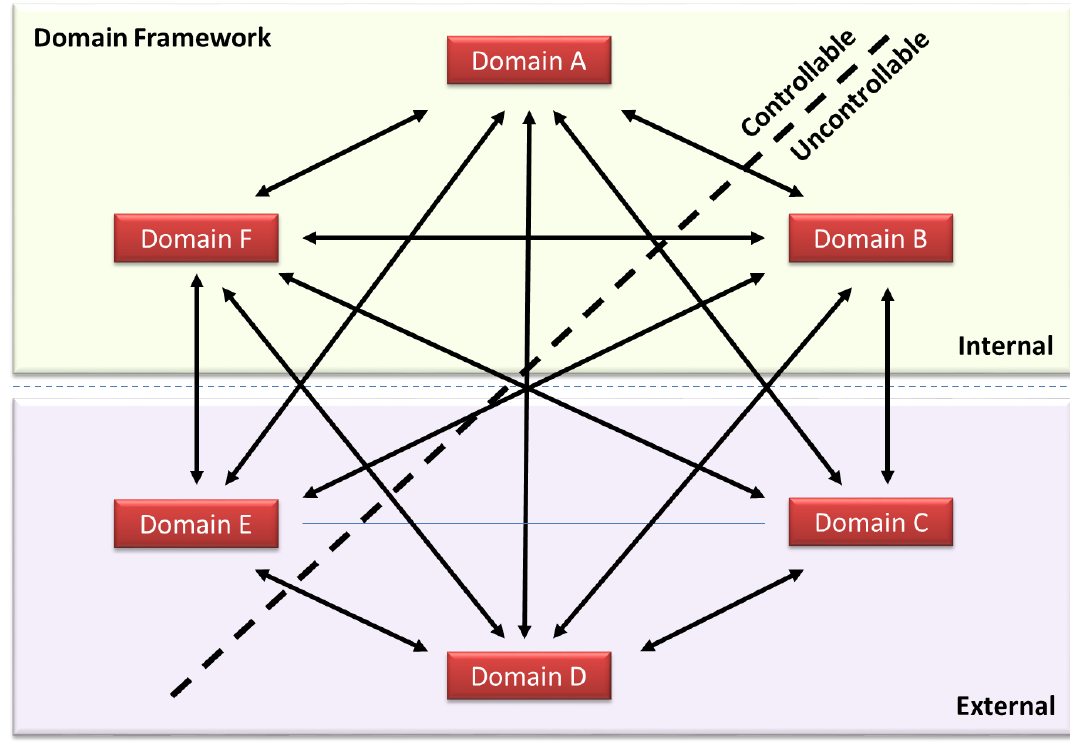
Figure 4. The domain framework. Figure 5. The domain